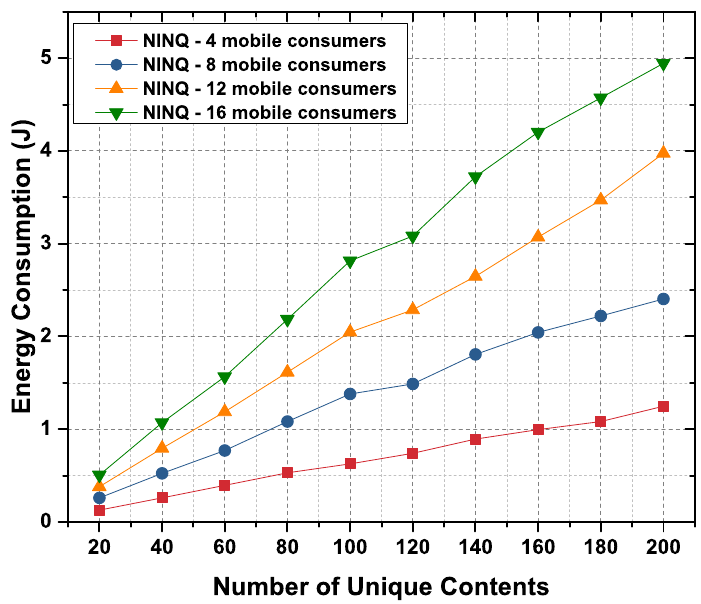
Figure 14. Energy consumption in an NINQ-based network as function of the number of unique content objects.